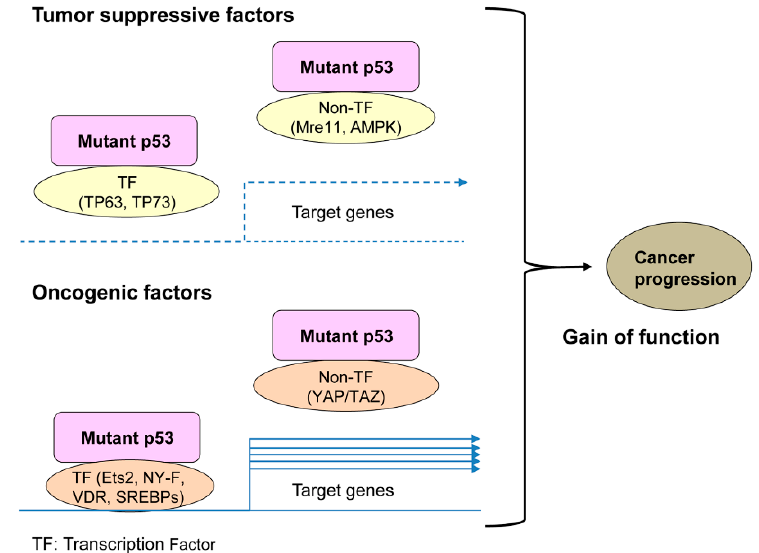
Figure 1. Mechanisms of mutant tumor suppressor p53 (mutp53) gain of function (GOF).